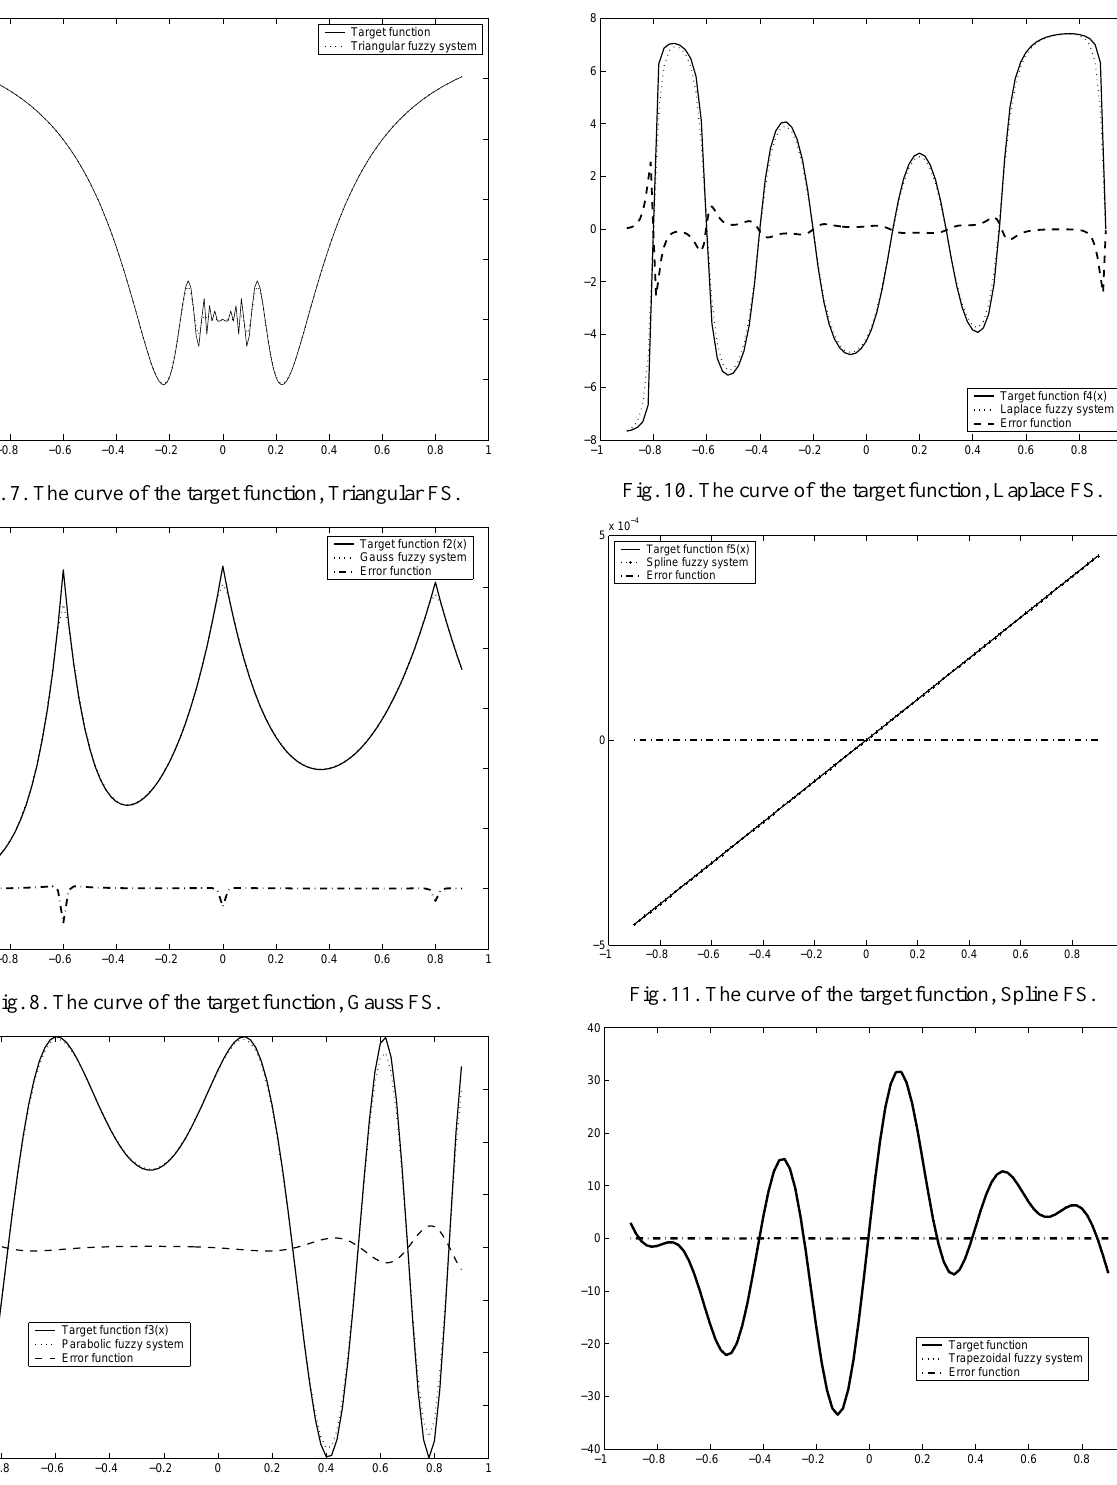
Fig. 12. The curve of the target function, Trapezoidal